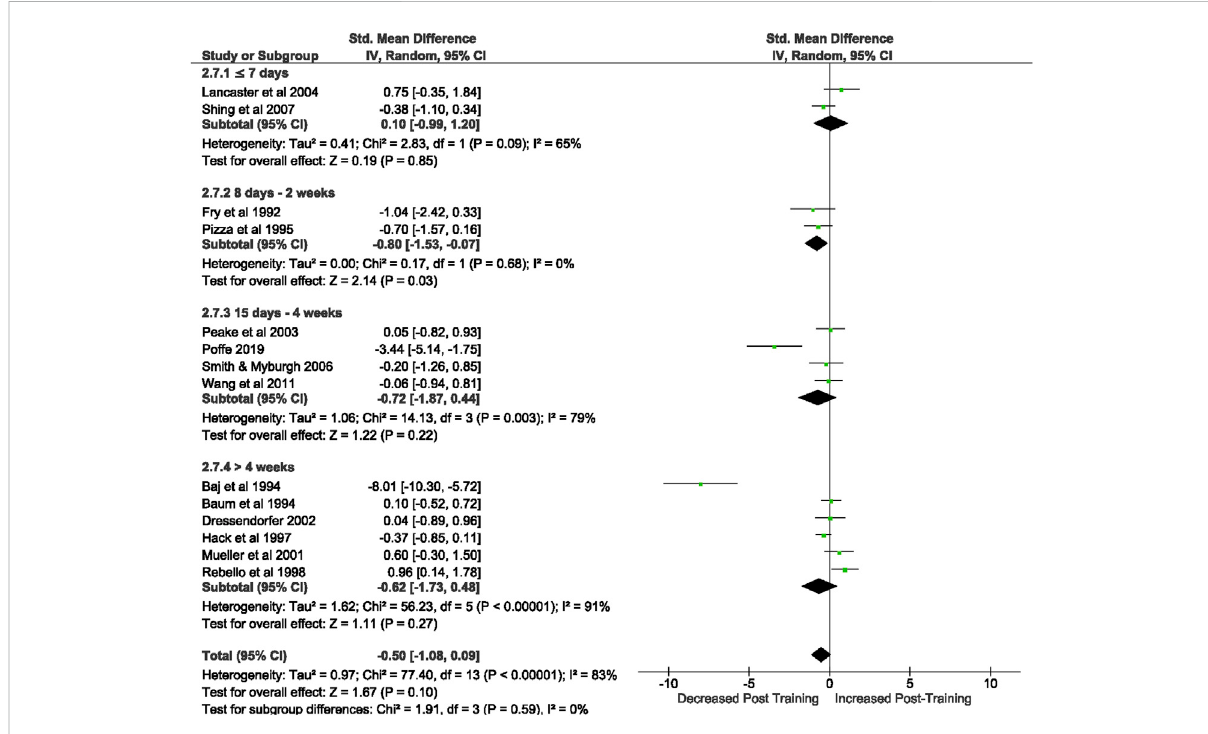
FIGURE 3 Effect of intensi fi ed training on resting CD3+ T cell counts, measured by FACS or Automated cell counter. Subgroup analysis is based on the durationofintensi fi edtrainingperiod; ≤ 7 days,8 days — 2 weeks,1 days — 4 weeksand > 4 weeks.Allstudiesusedhumanparticipants. CI Con fi dence